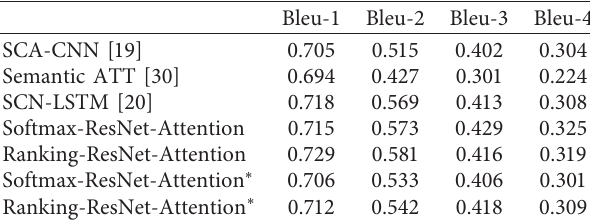
Table 4: The results of different caption methods on the